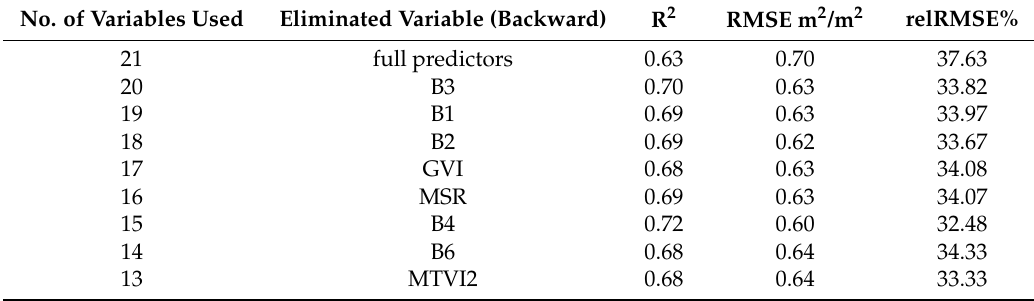
Table 3. Random forest (RF) model performance by backward elimination of variables for the wet season. RMSE: root mean square error.